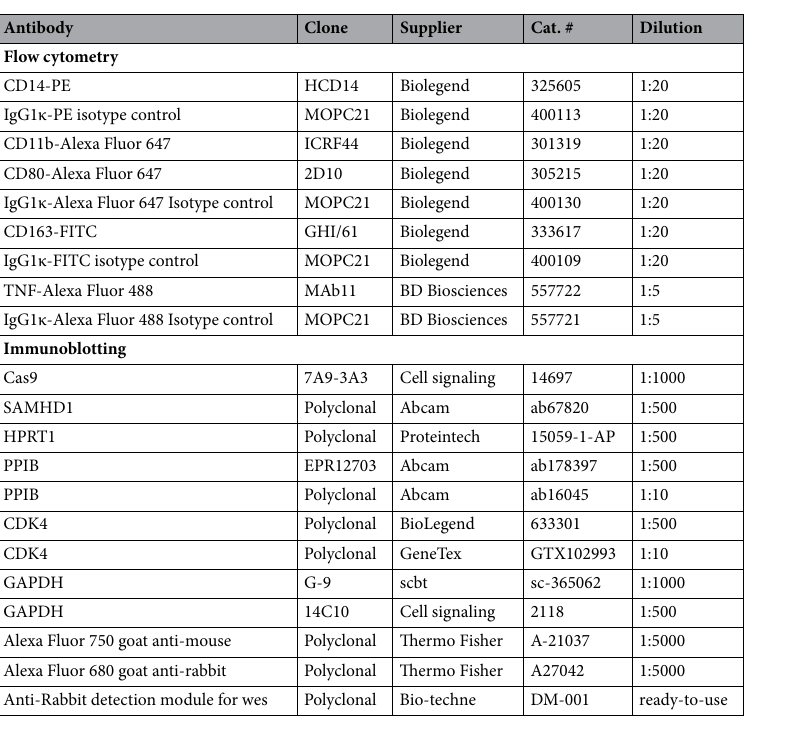
Table 2. Antibodies (for flow cytometry and immunoblotting assays).